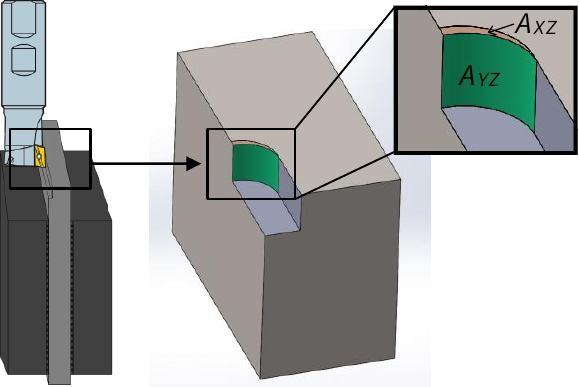
Figure 17. Machined volume showing the A YZ (green) and A XZ (yellow) areas.